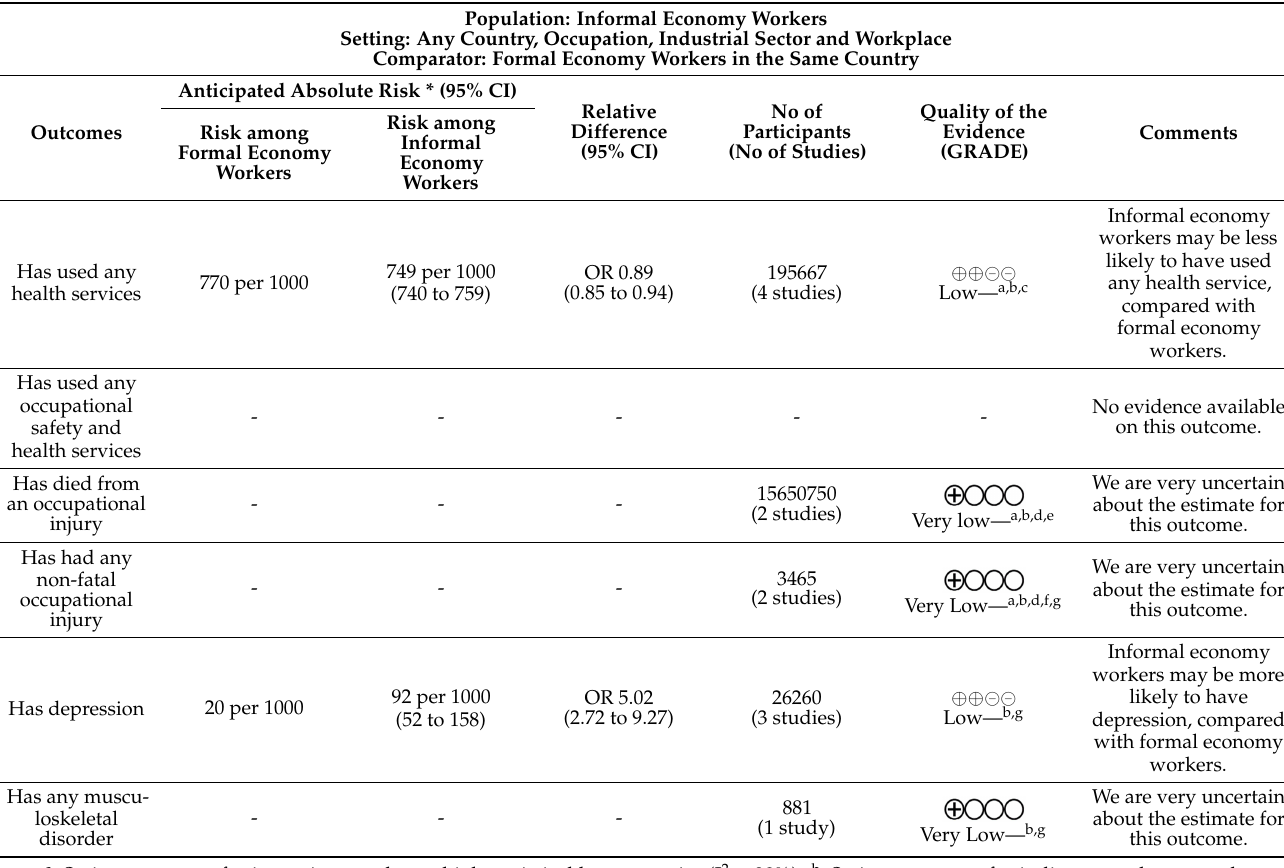
Table 4. Summary of findings: use of health services and health outcomes among informal economy workers, compared with formal economy workers.